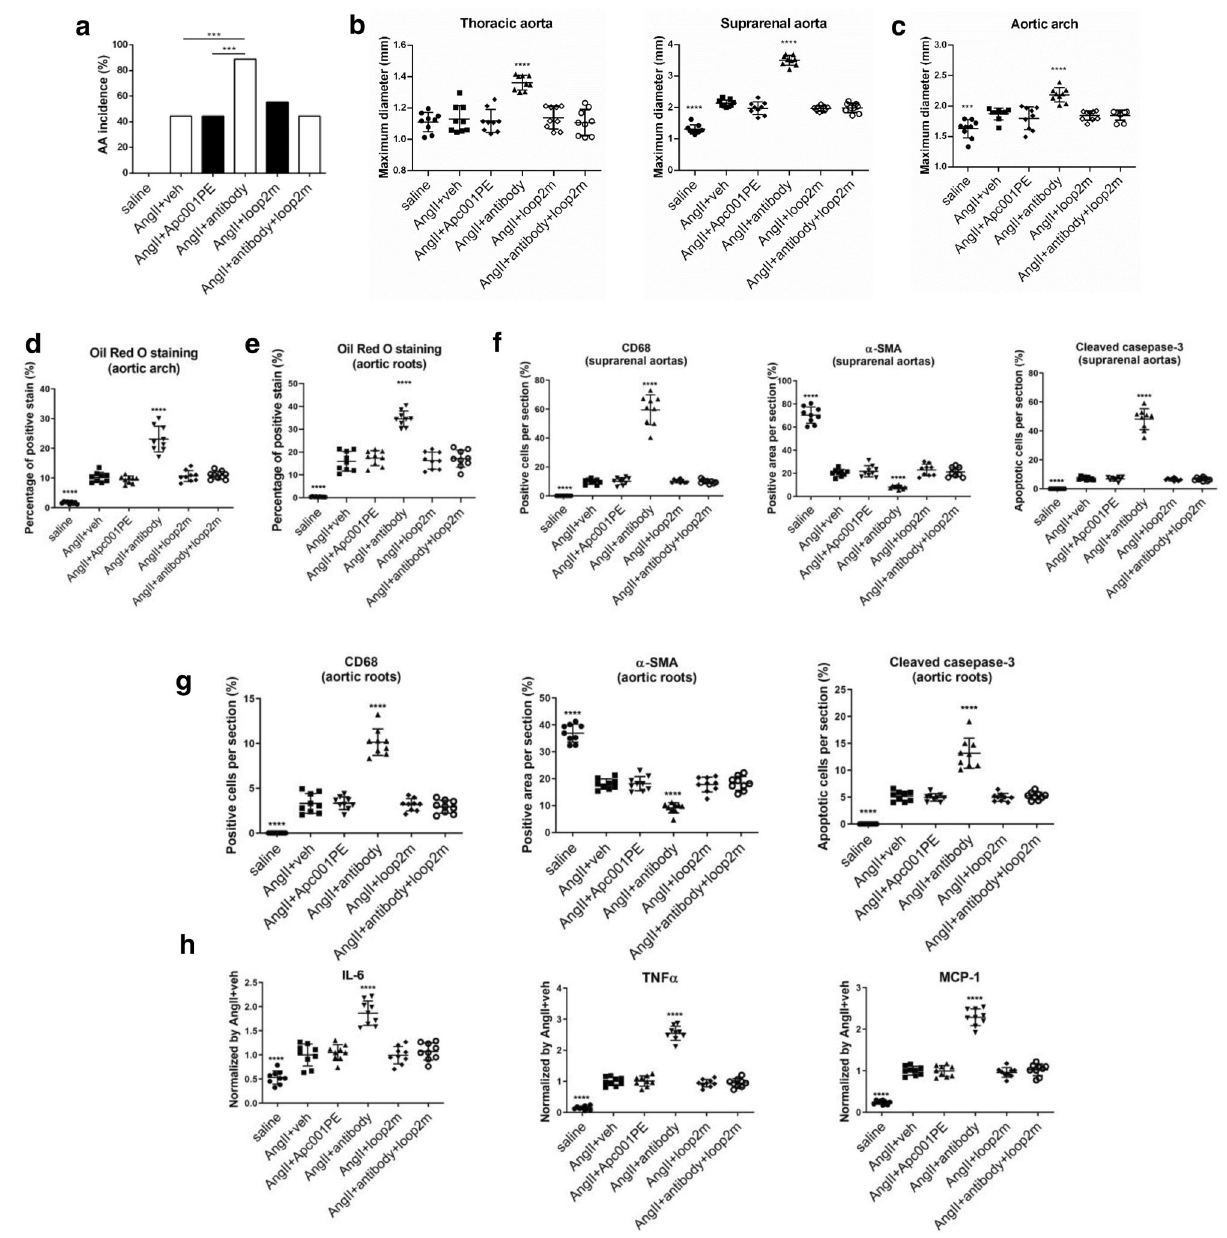
Fig. 5 Evaluation of whether targeting sclerostin loop3 by the speci fi c in vivo pharmacologic tool Apc001PE had an effect on cardiovascular events in ApoE − / − mice with AngII infusion. ApoE − / − mice with AngII infusion were subcutaneously administered vehicle, Apc001PE (12mg/kg), humanized therapeutic sclerostin antibody (25mg/kg), fatty acid-loop2m (6mg/kg), or humanized therapeutic sclerostin antibody and fatty acid-loop2m (6mg/kg) twice weekly for four weeks. a The incidence of AA formation. A two-sided chi-square test was performed to determine the difference between groups. *** p <0.005 . p = 0.0002 for all comparisons. b Ex vivo measurement of the maximum diameters of thoracic aortas and suprarenal aortas. Thoracic aorta: p <0.0001 (AngII + antibody); suprarenal aorta: p <0.0001 (saline), p <0.0001 (AngII + antibody). c Ex vivo measurement of the maximum diameters of the aortic arches. p = 0.0007 (saline), p <0.0001 (AngII + antibody). d Oil Red O staining of the aortic arch to quantify atherosclerosis. p <0.0001 (saline), p <0.0001 (AngII + antibody). e Quanti fi cation of positive staining per cryosection of aortic roots stained with Oil Red O. p <0.0001 (saline), p <0.0001 (AngII + antibody). f , g Quanti fi cation of the expression of CD68, α -SMA and cleaved caspase-3 in suprarenal aortas ( f ) and aortic roots ( g ) by immunohistochemical analysis. For ( f ): CD68: p = 0.0001 (saline), p <0.0001 (AngII + antibody); α -SMA: p = 0.0001 (saline), p <0.0001 (AngII + antibody); cleaved caspase-3: p <0.0001 (saline), p <0.0001 (AngII + antibody). For ( g ): CD68: p <0.0001 (saline), p <0.0001 (AngII + antibody); α -SMA: p <0.0001 (saline), p <0.0001 (AngII + antibody); cleaved caspase-3: p <0.0001 (saline), p <0.0001 (AngII + antibody). h Serum levels of in fl ammatory cytokines and chemokines. IL-6: p <0.0001 (saline), p <0.0001 (AngII + antibody); TNF- α : p <0.0001 (saline), p <0.0001 (AngII + antibody); MCP-1: p <0.0001 (saline), p <0.0001 (AngII + antibody). For ( b – h ), data were expressed as the mean±standard deviation. n = 9 per group. * p <0.05, ** p <0.01, *** p <0.005, and **** p <0.0001 for a comparison vs. AngII + veh by one-way ANOVA with Tukey ’ s post-hoc test. Note: AngII: angiotensin II; IL-6: interleukin 6; MCP-1: monocyte chemoattractant protein-1; TNF- α : tumour necrosis factor alpha; CD68: macrophage biomarker; α -SMA: contractile cell biomarker; cleaved caspase-3: apoptotic cell biomarker; loop2m: the loop2 mutant (GPARLLPNAIGR AAAWRPSGPDFR). Source data are provided as a Source Data fi